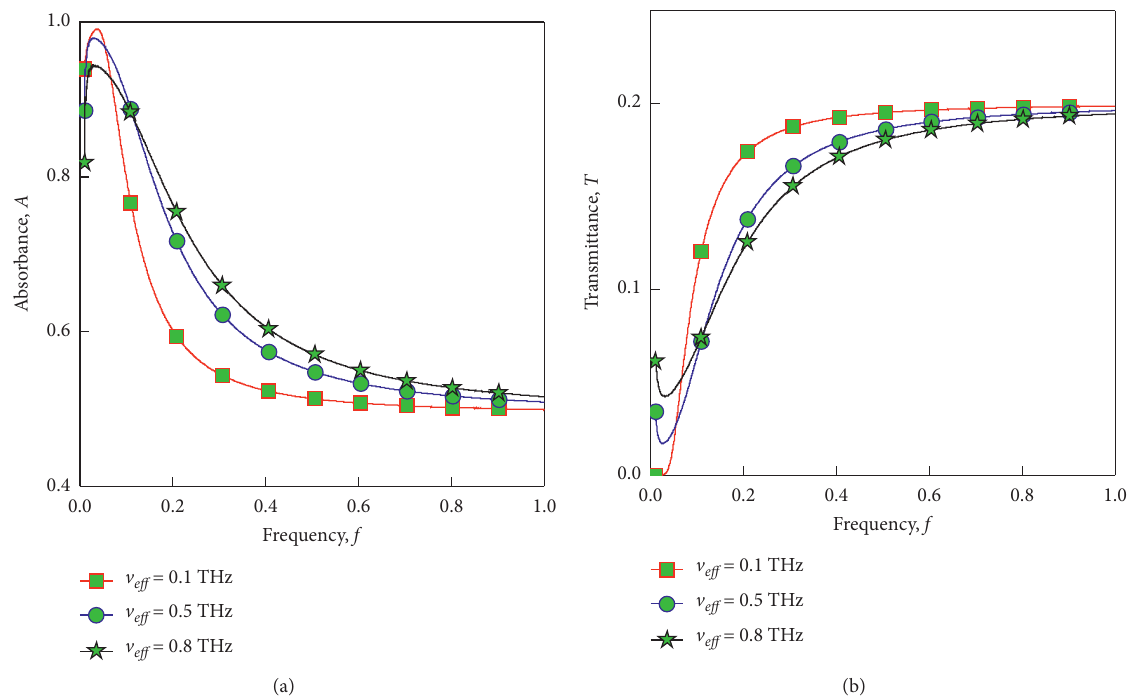
Figure 8: Absorbance and transmittance versus wave frequency for different collision frequencies in a dusty plasma